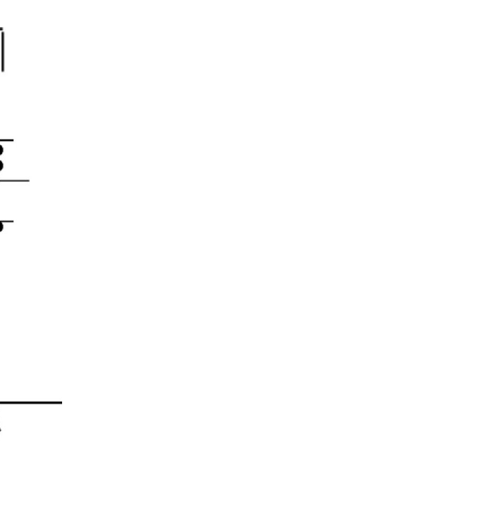
Fig 5. Ablative RT combined with α CD47mAb increased IFN γ expressing cells in tumors. The percentage of CD8 + cells that expressed IFN γ in the spleen are shown. Data are displayed as the mean (SD) and were analyzed using the Tukey’s Multiple Comparison Test ( � : P < 0.05, �� : P < 0.01).